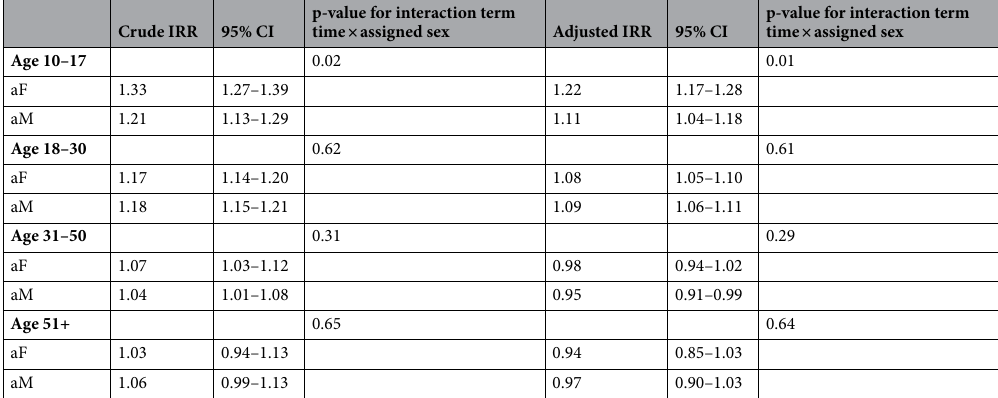
Table 1. Crude and coverage-adjusted Poisson-derived incidence rate ratios (IRR) with 95% confidence intervals by sex and age groups as well as interaction terms for time trends and assigned sex,